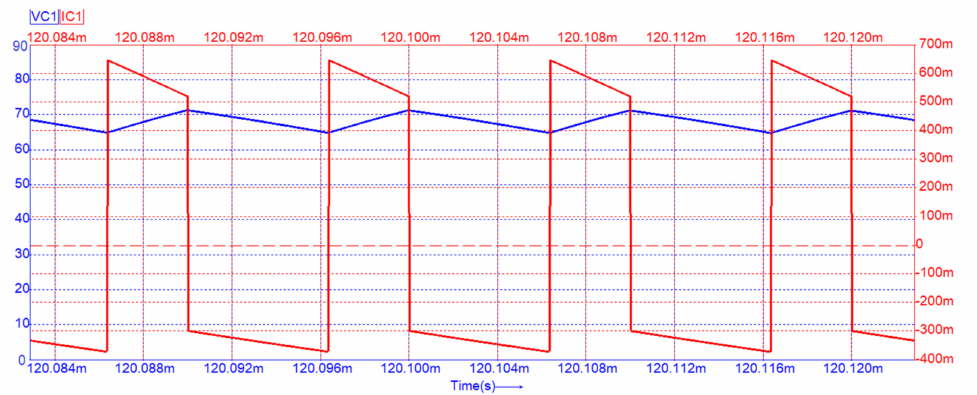
Figure 13. Voltage and current for the internal capacitor C 1